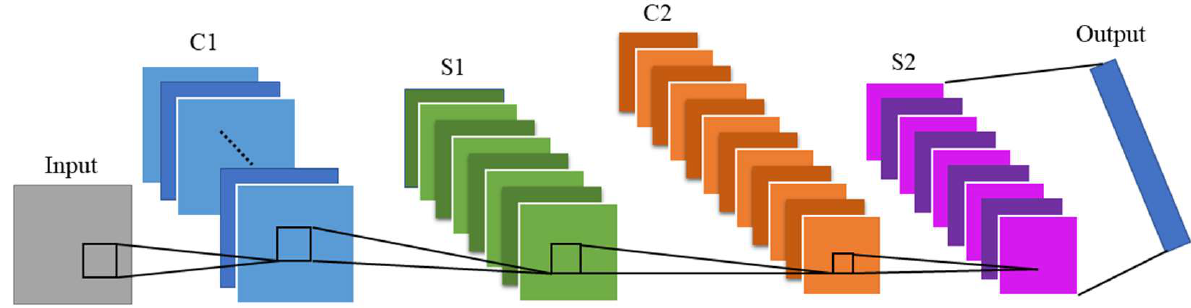
Figure 4. Architecture of the CNN.